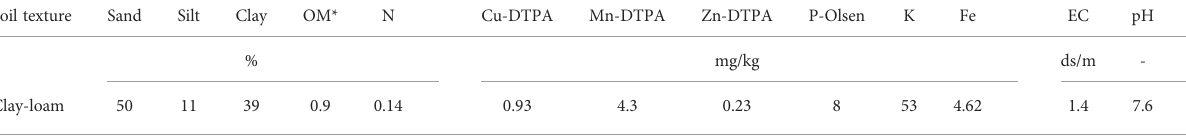
TABLE 2 Physiochemical properties of the soil used in the present experiment.